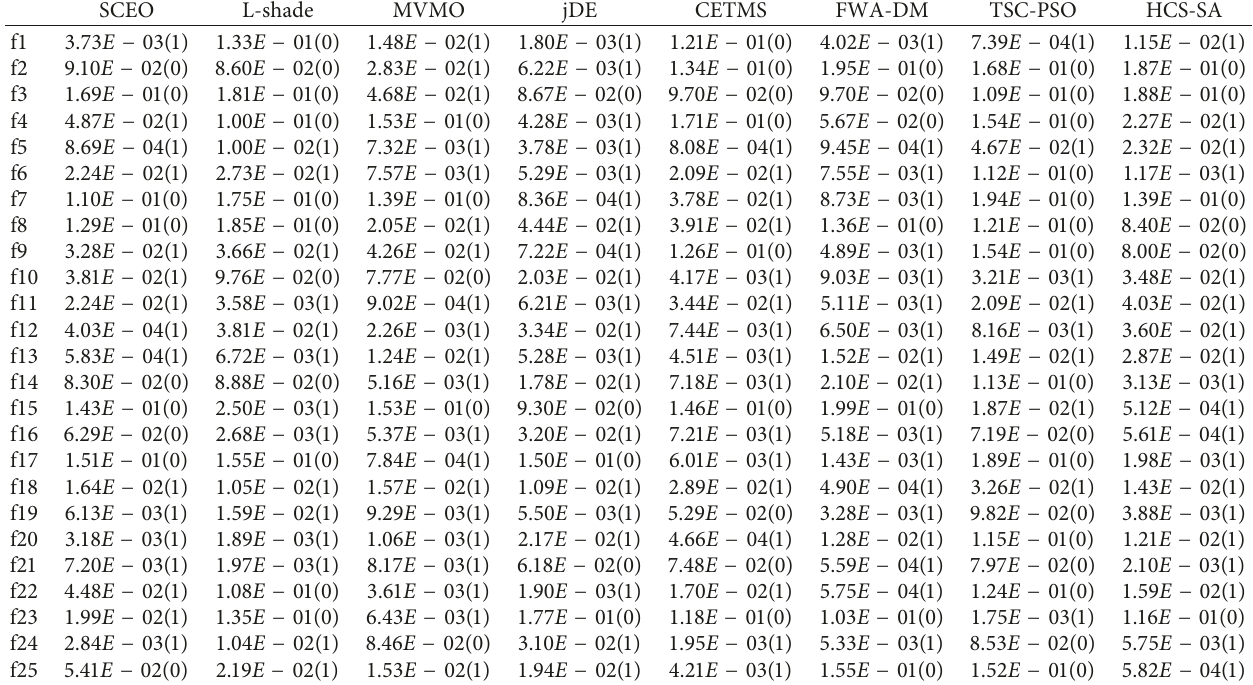
Table 17: Shapiro–Wilk test for SCEO, L-SHADE [36], MVMO [37], jDE [39], CETMS [40], FWA-DM [41], TSC-PSO [42], and HCA-SA [43] algorithms on CEC 2014